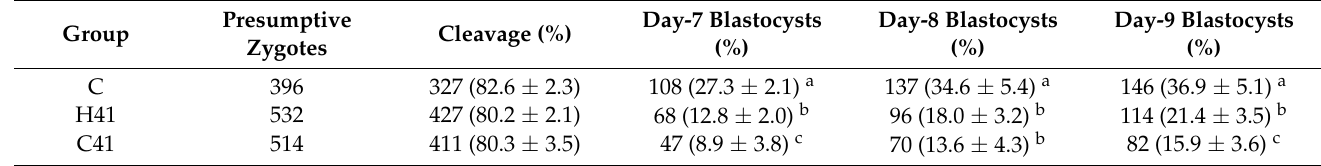
Table 3. Blastocyst formation rates in control embryos (group C), embryos exposed to elevated temperature for 24 h (C41) and embryos exposed to elevated temperature with the addition of HSP70 in the IVC medium (group H41).